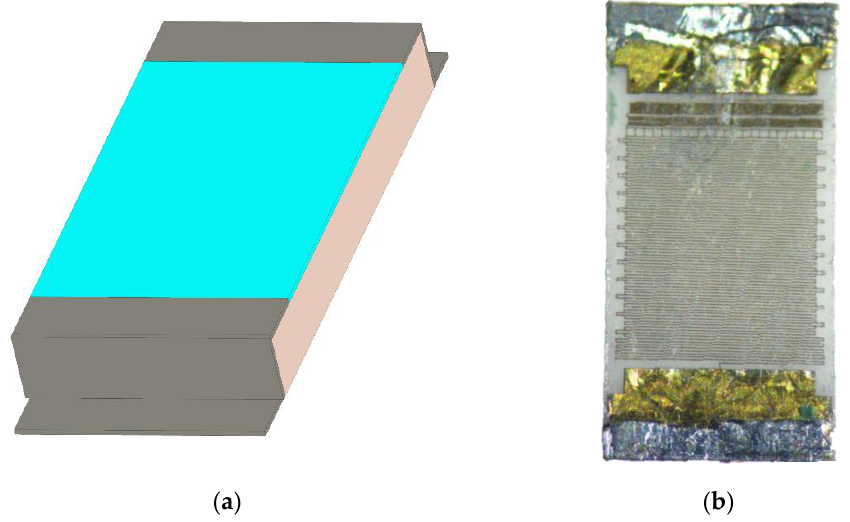
Figure 5. ( a ) Simplified resistor used in the simulation in the Dassault Systémes CST Studio Suite 2021 ® Microwaves and RF solver. ( b ) Real resistor (package 1206: length l = 3.2 mm, width w = 1.6 mm, and height h = 0.42 mm) with the protective cover film removed, the meander-shaped thin current path is also visible between the two metalized end faces on the top and bottom.